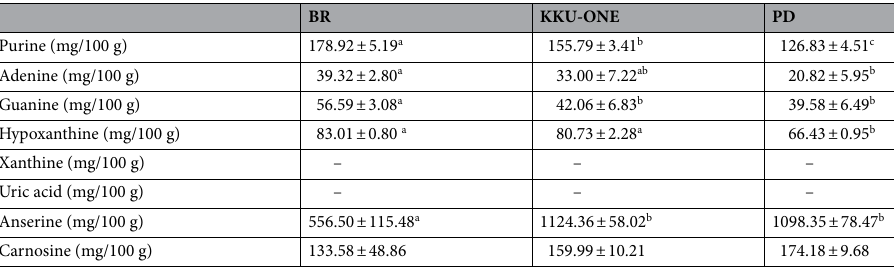
Table 2. The purine, anserine, and carnosine content in breast meat from different chicken breeds. Data are expressed as the mean ± SEM. (n = 7 samples/group); BR: commercial broiler, KKU-ONE: commercial broiler × Thai native crossbred, PD: Thai native chicken (Pradu Hang Dam); Values within a row bearing different letters (a–c) are significantly different at p < 0.05.